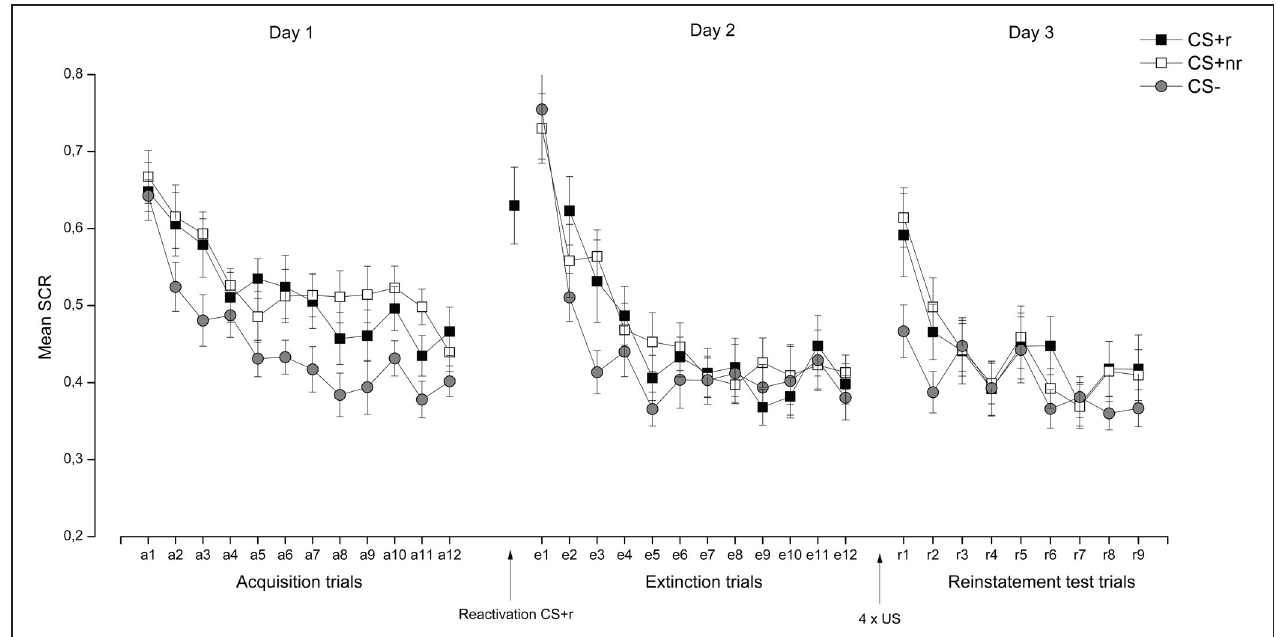
FIGURE 3 | Experiment 1: Reactivation of fear-relevant stimuli indexed by skin conductance responses (SCR). Mean SCR during the presentation of the fear conditioned stimuli (CS + r, CS + nr), and the control stimulus